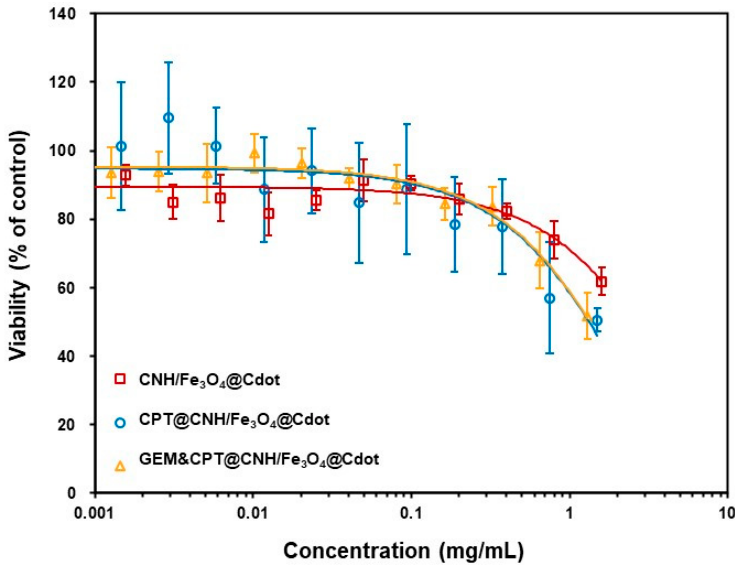
Figure 9. Cell viability of CNH/Fe 3 O 4 @Cdot, CPT@CNH/Fe 3 O 4 @Cdot, and GEM&CPT@ CNH/Fe 3 O 4 @Cdot in NCI-N87 cells. The data are represented as means ± SD, ( n =